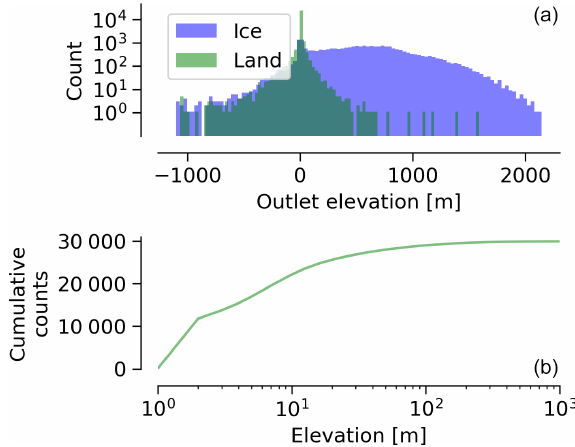
Figure 18. (a) Histogram of outlet elevations. (b) Cumulative dis- tribution of absolute land outlet elevation. More than 75% of land outlets occur within ± 10m and 90% within ±